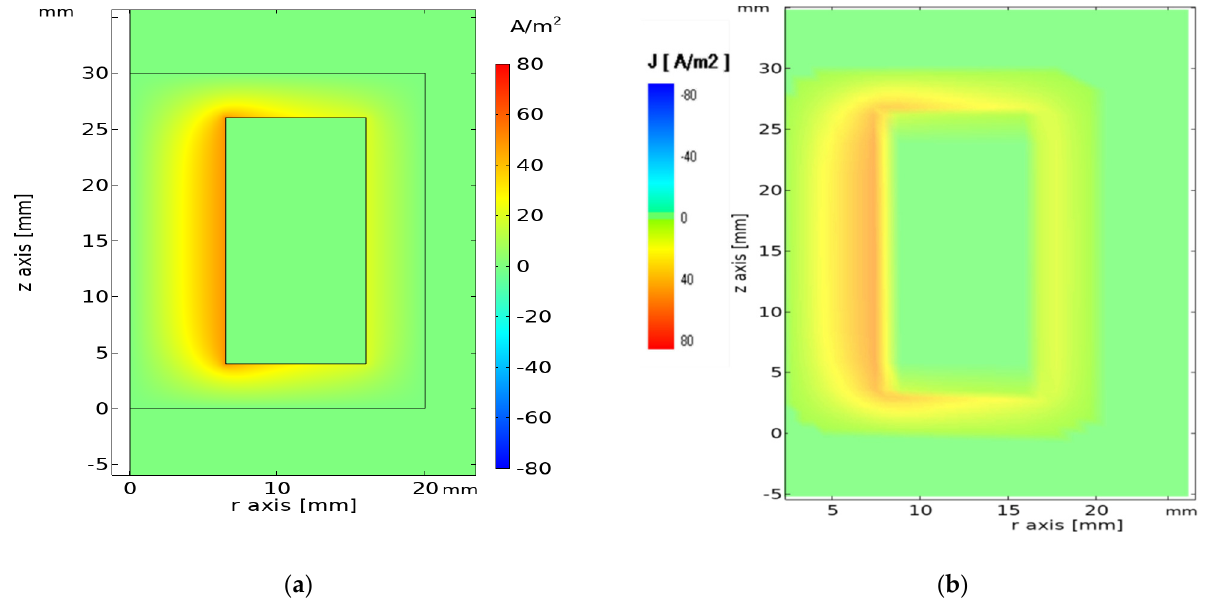
Figure 20. ( a ) Distribution of the eddy current density in the ferrite core at time t = 1 ms obtained by Comsol Mutliphysics. ( b ) Distribution of the eddy current density in the ferrite core at time t = 1 ms obtained by the proposed approach.